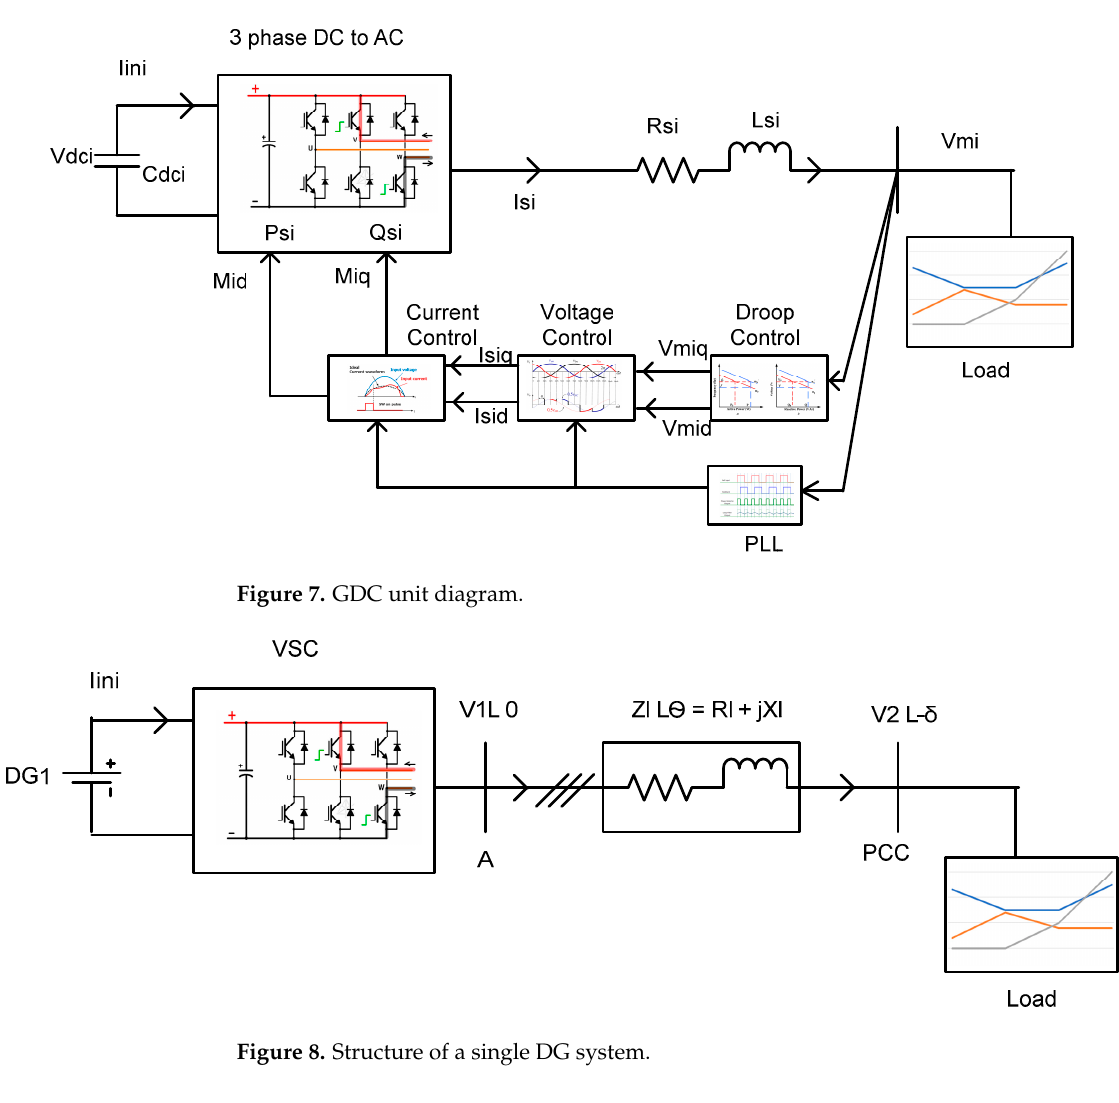
Figure 8. Structure of a single DG system.